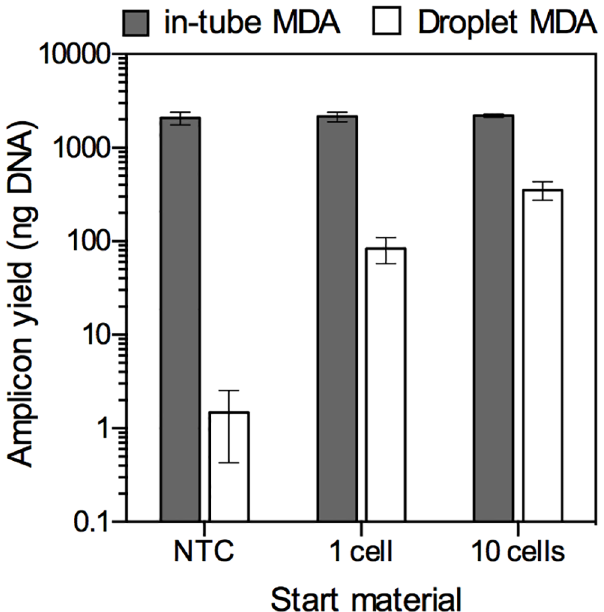
Fig 3. Amplicon yields by in-tube MDA and droplet MDA. No template control (NTC), 1 and 10 E . coli cells were used as start material. In the droplet MDA, lysed cells were pumped into the droplet generators and genome DNA fragments were randomly encapsulated into picoliter droplets consist of MDA mixture (67 pL per droplet, total 1.5× 10 5 droplets). After 180 min of MDA reaction, the yields were evaluated following droplet breaking and amplicon purification. A total of 10 μ L of MDA mixture was used in both droplet MDA and in-tube MDA reactions.